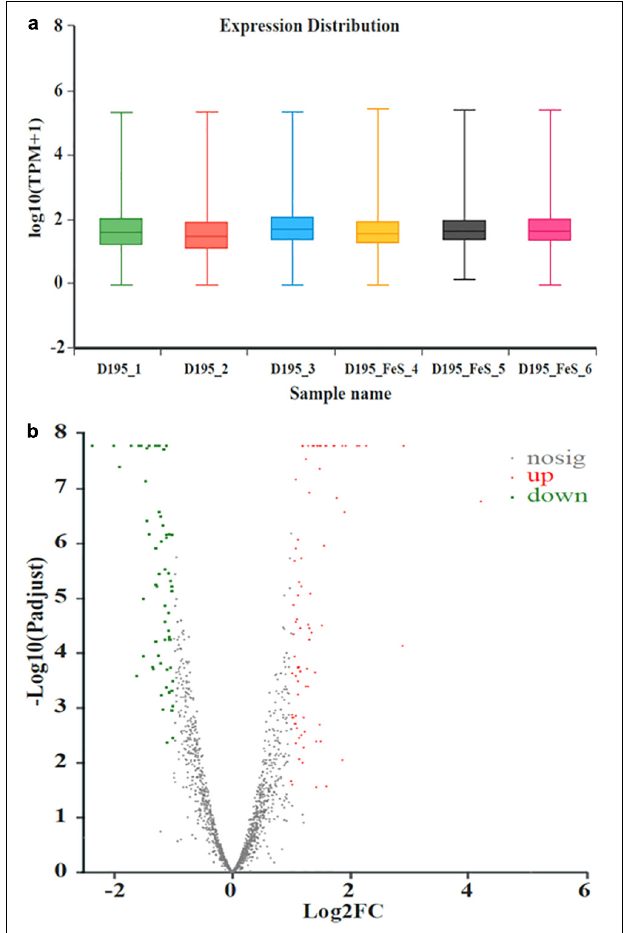
FIGURE 5 | The expression distribution of transcripts for Dhc 195 (a) ; Microarray signal from Dhc 195 of two cultures (with and without FeS) (b) ( ≥ 2-fold difference, p -value < 0.05). The red dots represented the up-regulated genes and the green dots represented the down-regulated genes with the addition of FeS. All measurements were avenges from three biological